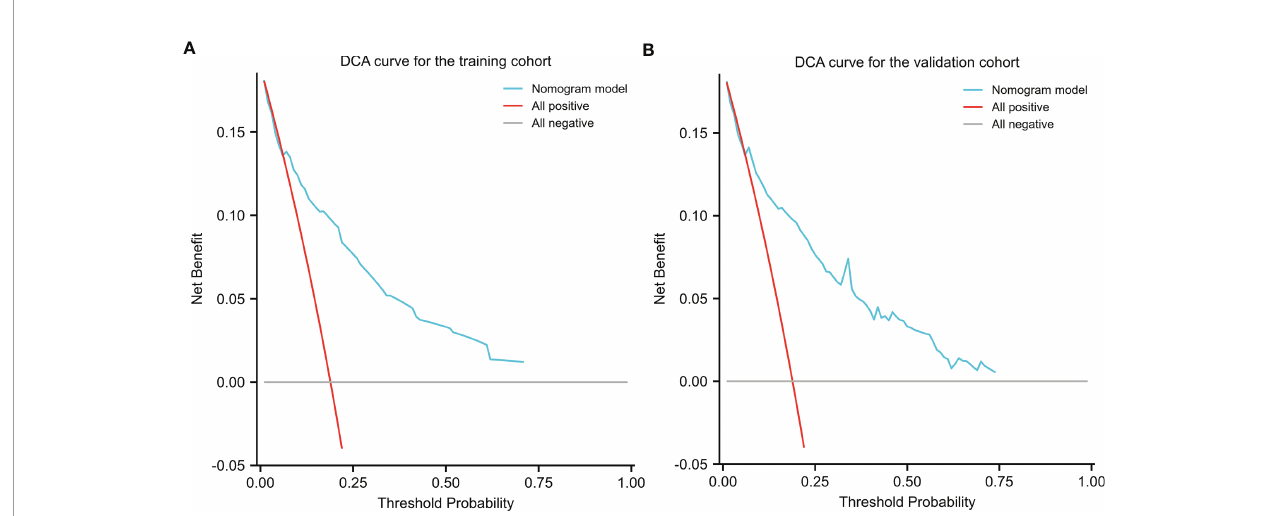
FIGURE 7 | Decision Curve Analysis (DCA) for the nomogram in the training (A) cohort and validation cohort (B) . Threshold probability and net bene fi t were represented by the X-axis and the Y-axis, respectively. The blue line represented the net bene fi t of the nomogram at different threshold probabilities. The area between the “ All negative ” (gray line) and “ All positive ” (red line) in the DCA curve indicated the clinical utility of the